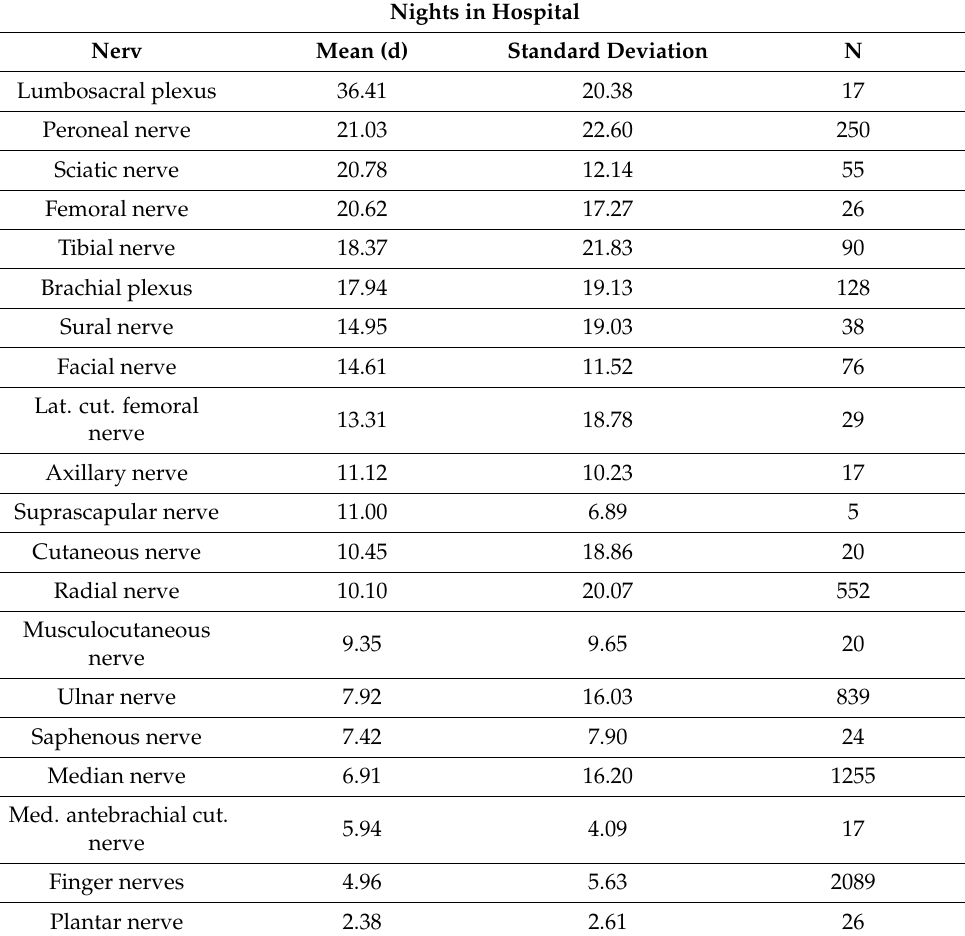
Table 1. Duration of inpatient treatment according to different nerve injuries. Trunk and lower extremity lesions show a longer duration of inpatient treatment. Nights spent in the hospital are shown. Therefore, a duration of two nights in hospital equals three days in hospital. This format was used due to internal regulations and to eliminate data irritation with outpatient treatment who have a day in the hospital but no